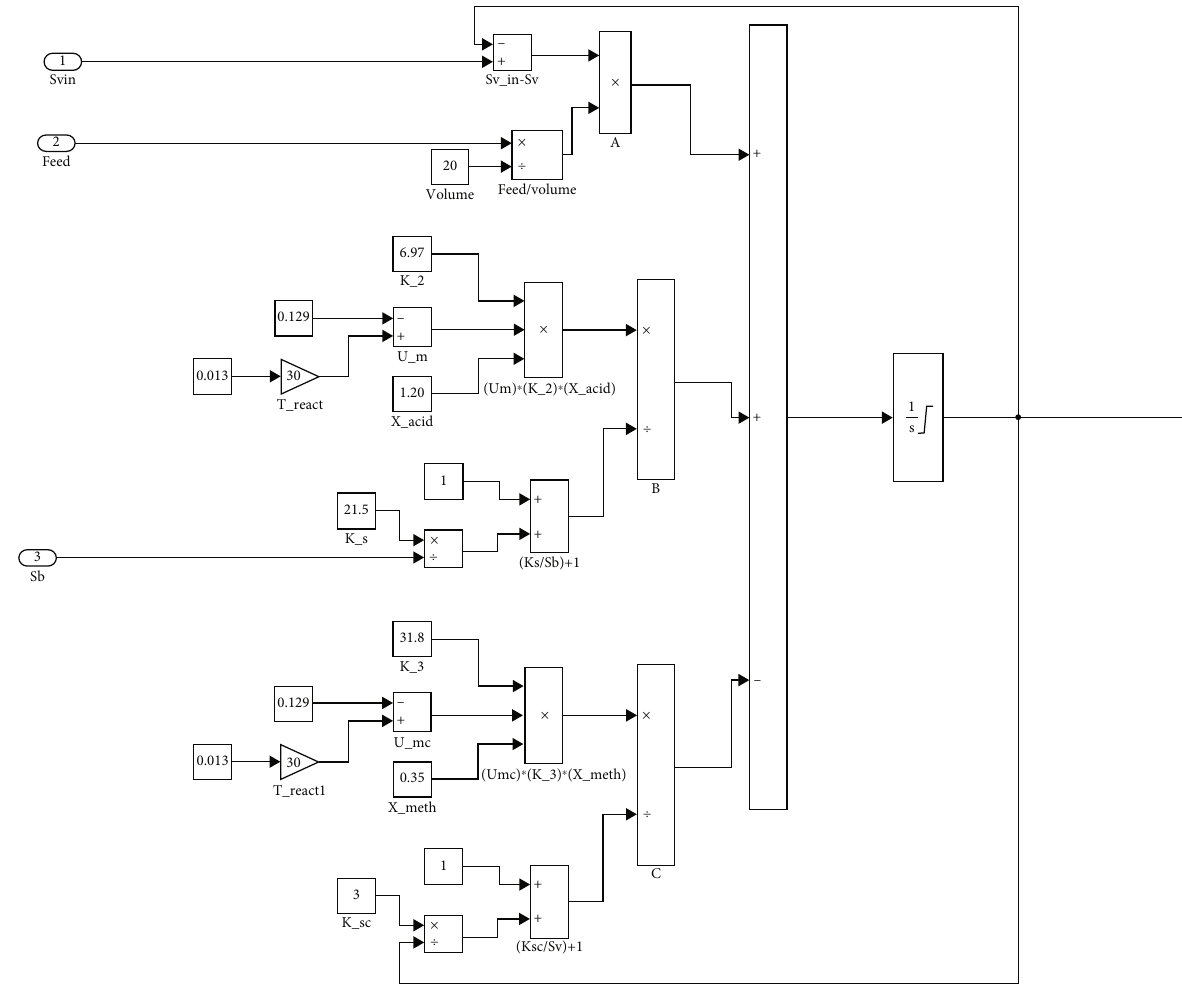
Figure 4: Simulink model of